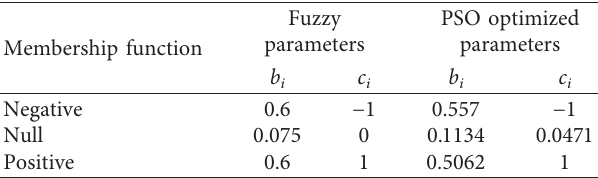
Table 4: Fuzzy-PSO optimized result of ECF for microgrid